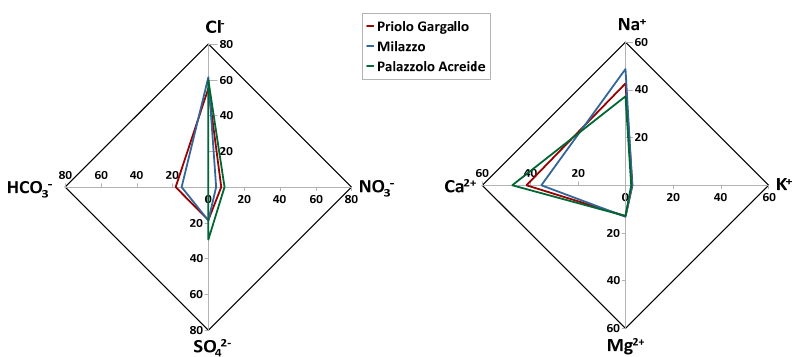
Figure 4. Major ions’ relative abundances (%), on an equivalent basis, in the study areas of Priolo Gargallo (red), Milazzo (blue), and Palazzolo Acreide